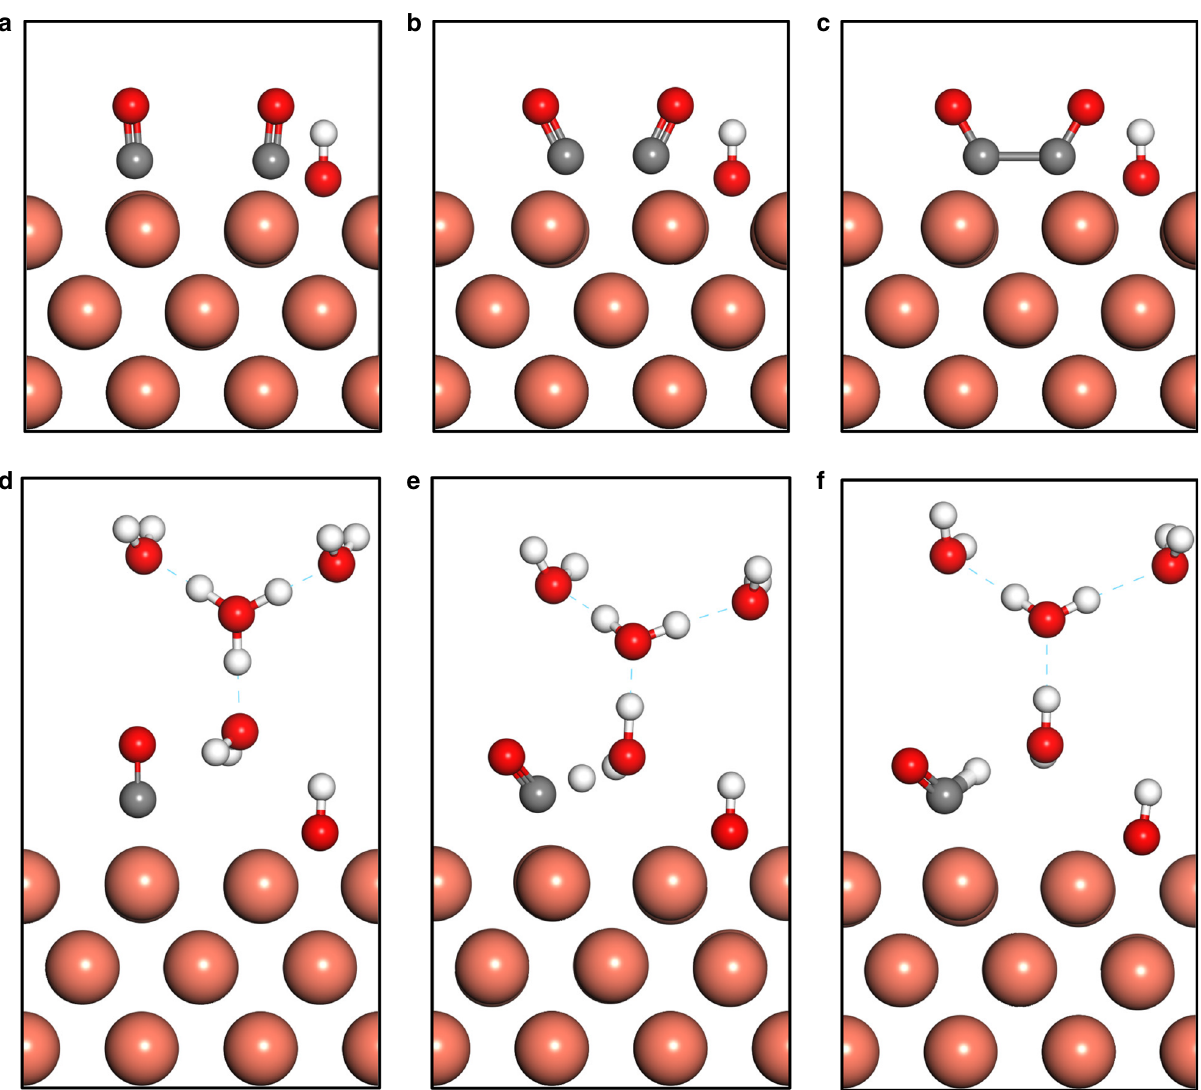
Fig. 4 Computational model. Representative structures of *CO dimerization at initial states ( a ), transition states ( b ), and fi nal states ( c ). Representative structures of *CO hydrogenation at initial states ( d ), transition states ( e ), and fi nal states ( f